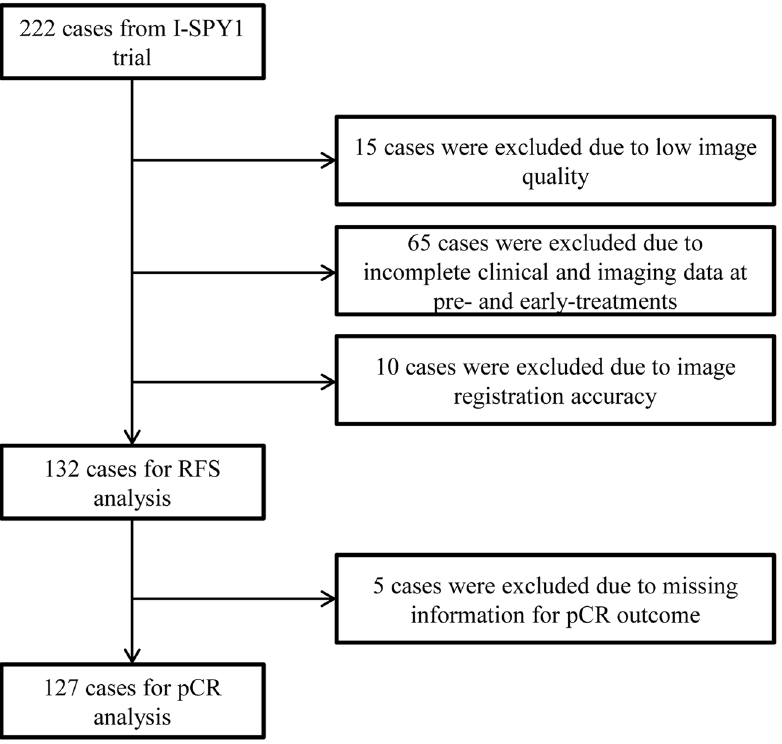
Figure 1. Inclusion and exclusion criteria from the ISPY-1/ACRIN 6657 trial